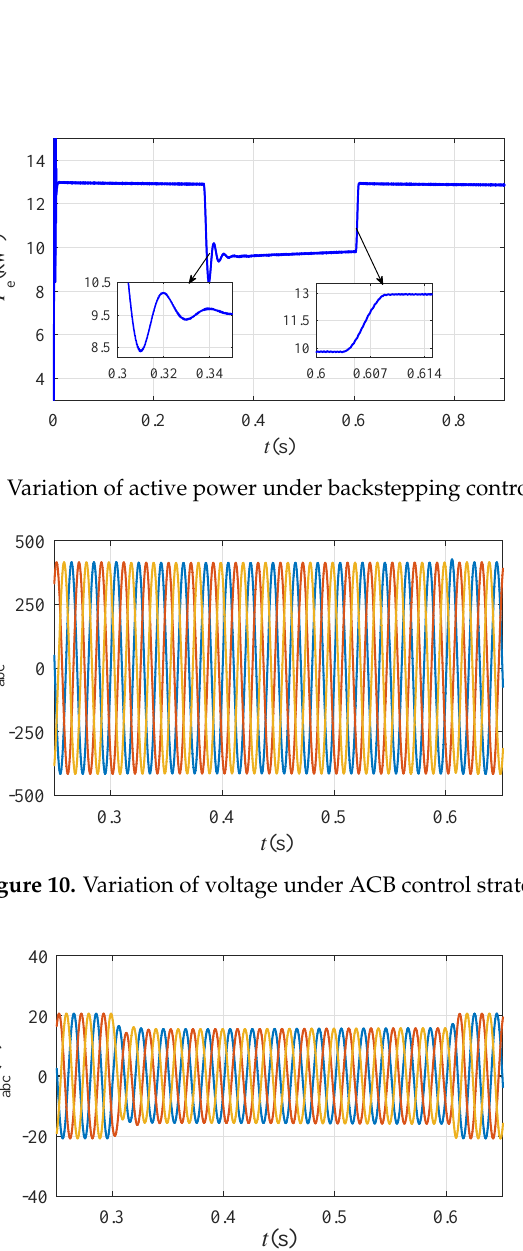
Figure 11. Variation of current under ACB control strategy.